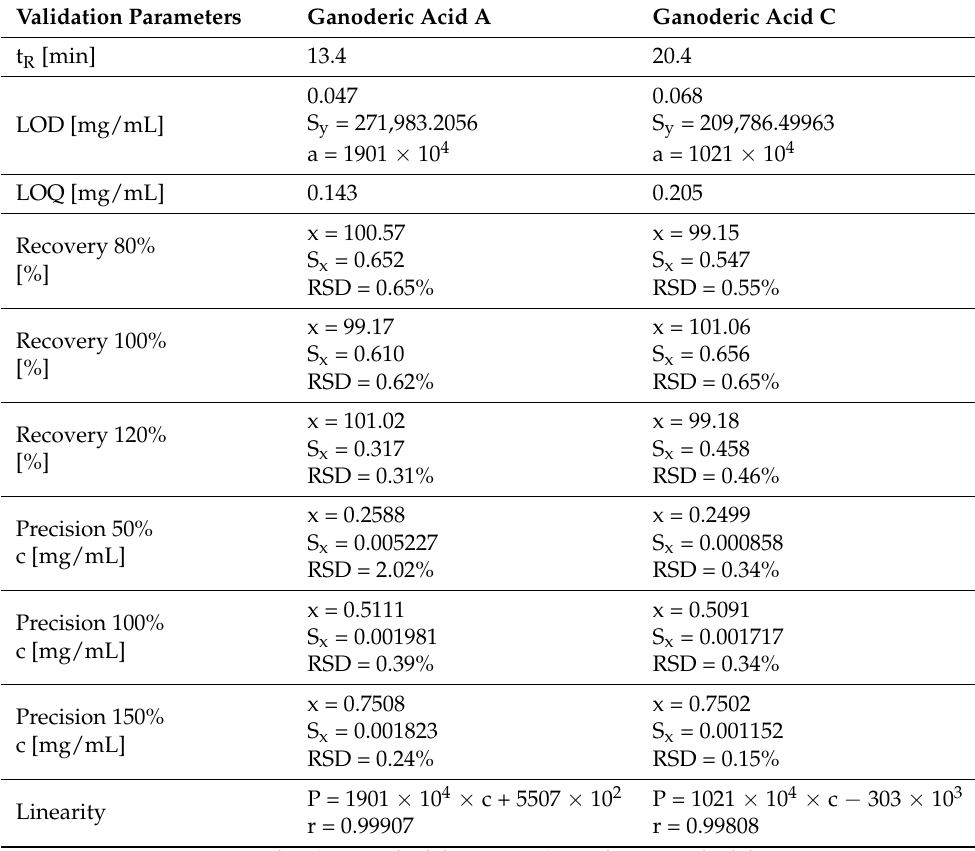
Table 2. Validation of the developed methods with statistical evaluation for HPLC